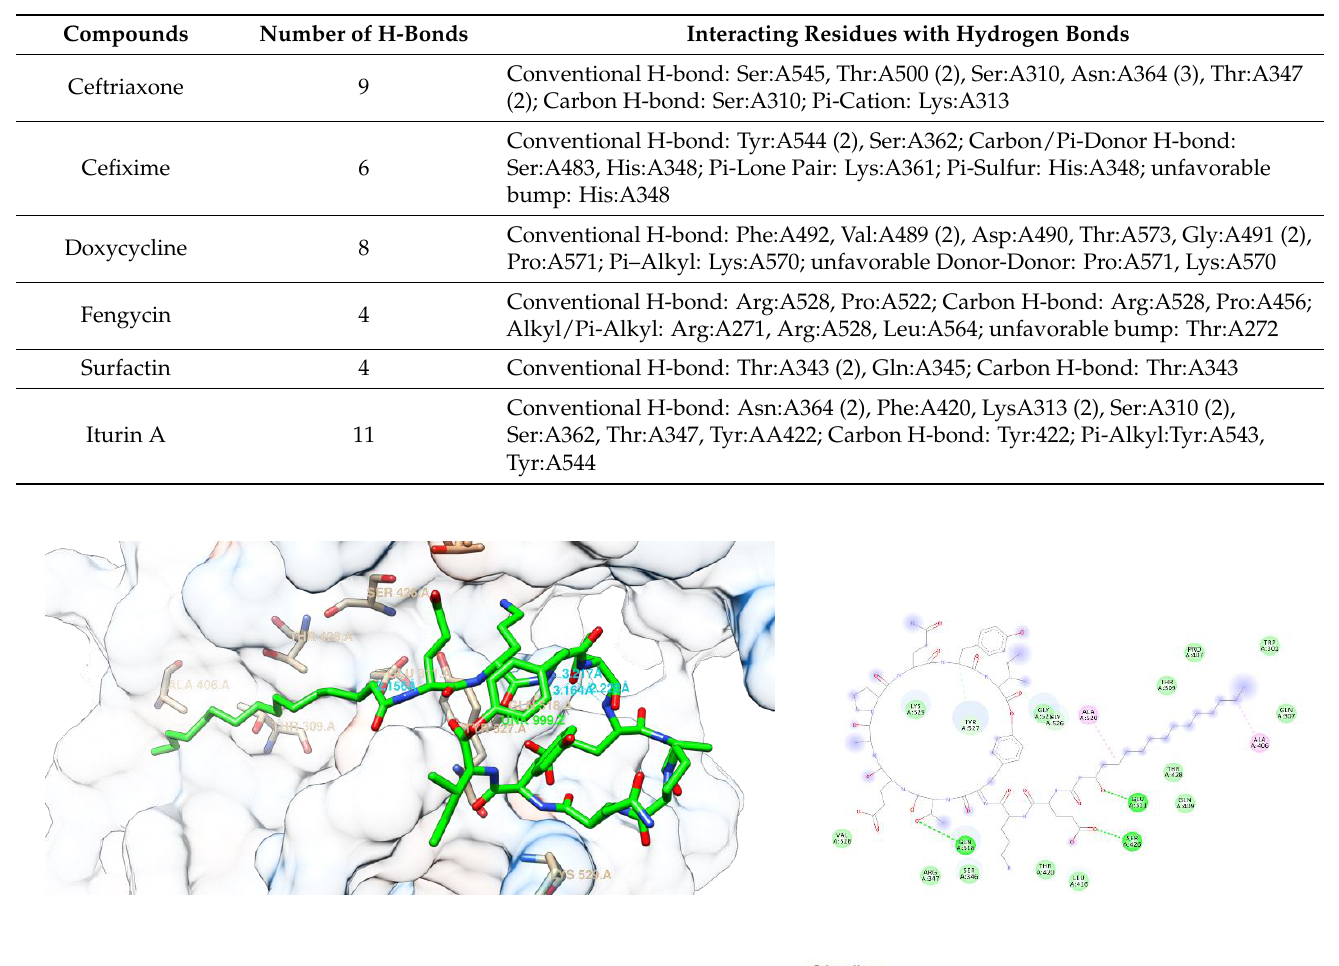
Table 5. Analysis of the compounds’ interactions with receptor PBP 2.